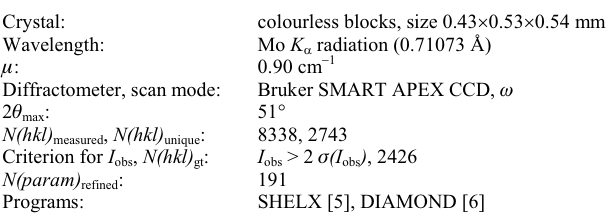
Table 1. Data collection and handling.